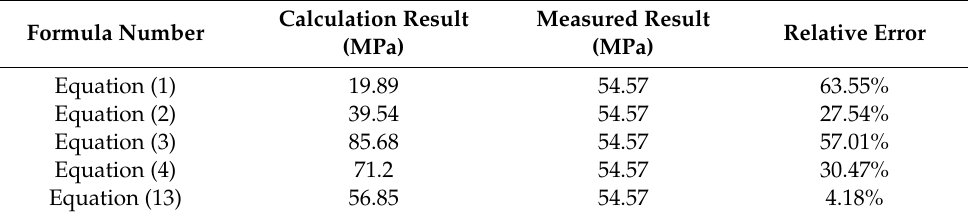
Table 9. Calculation results of di ff erent empirical